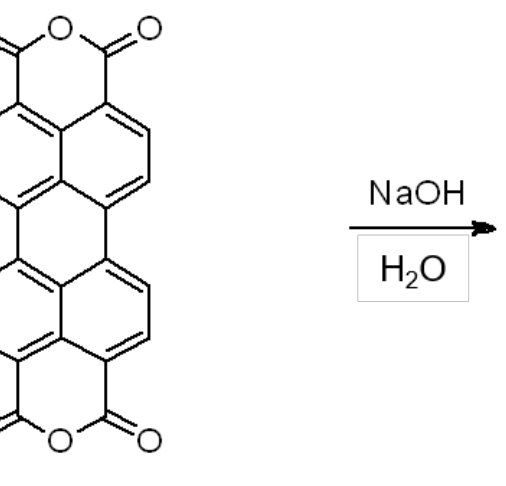
Figure 1. Synthesis of Na-Pery.